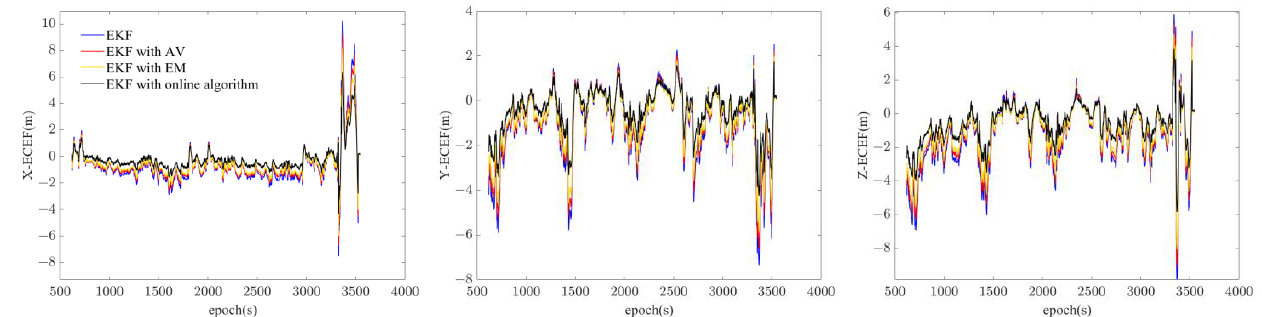
Figure 11. The navigation error of the three models in X, Y, and Z of ECEF.